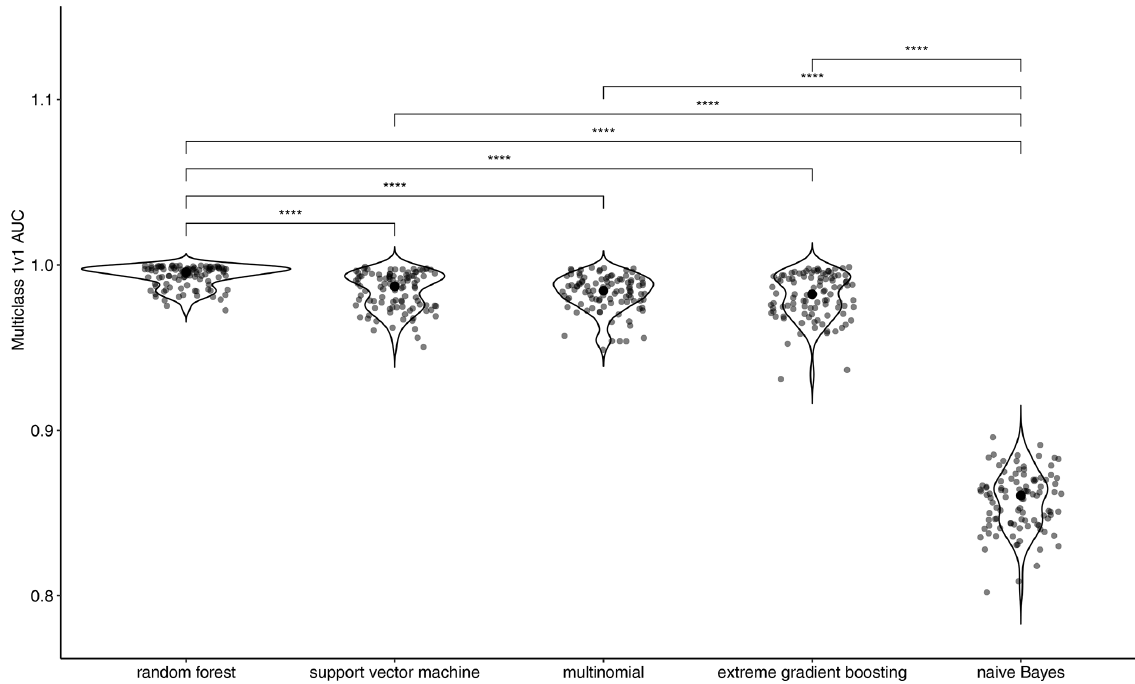
Figure 3. Machine learning performance for prediction of the location of study for each document using both human-derived and text-mined labels ( n = 3494). Brackets highlight statistical differences between distributions.